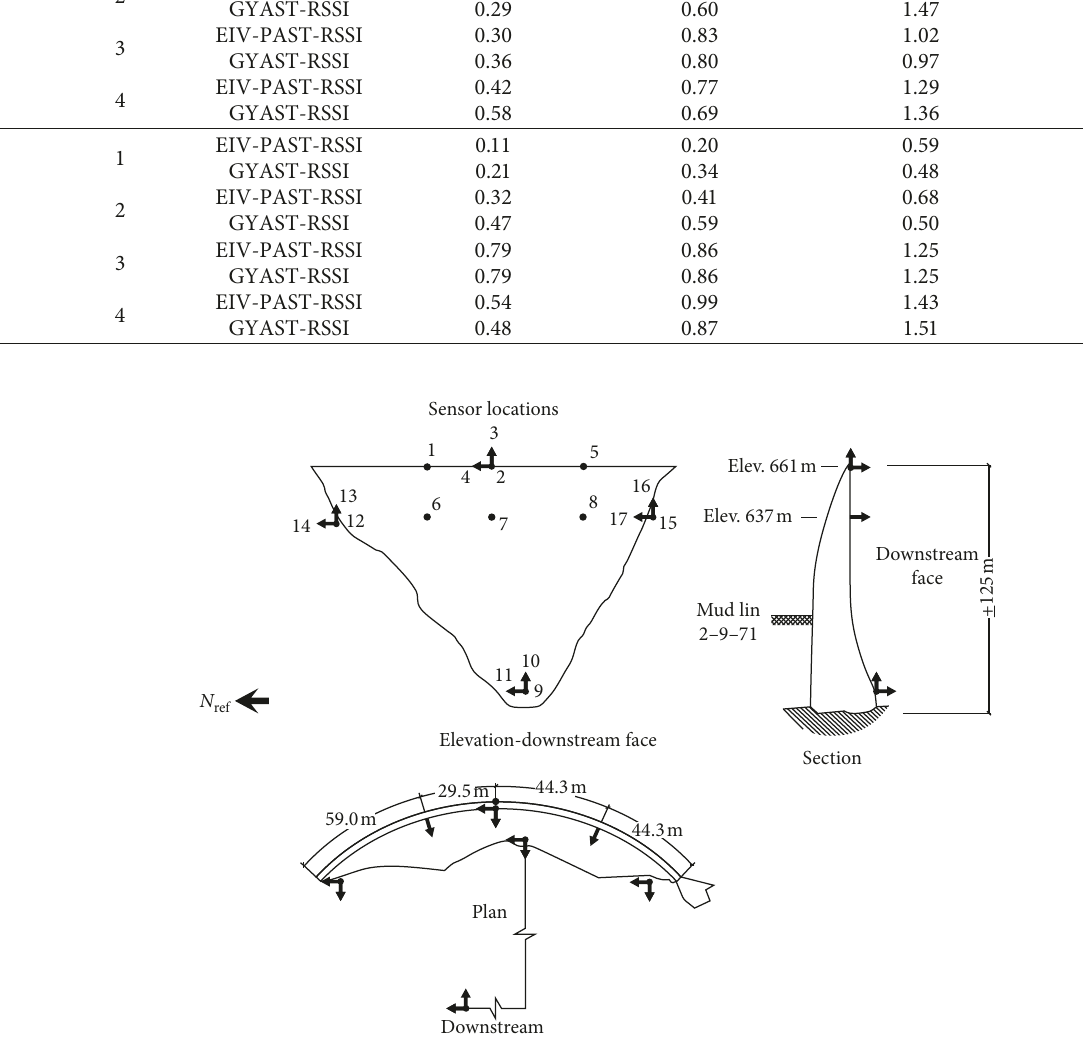
Figure 14: The arrangement of the accelerographs on the Pacoima arch dam. Table 2: Information about three major California